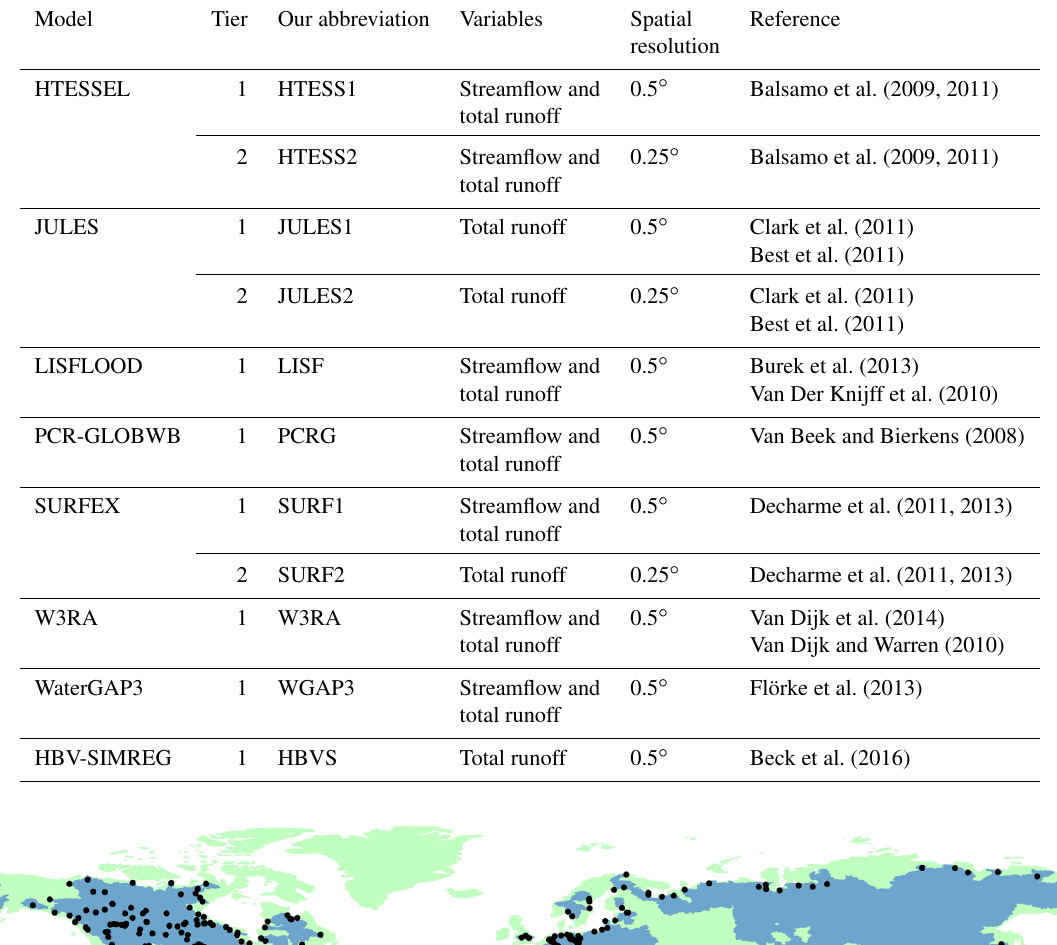
Table 1. Model outputs from tiers 1 and 2 of the eartH2Observe project used to derive the synthesis runoff product.